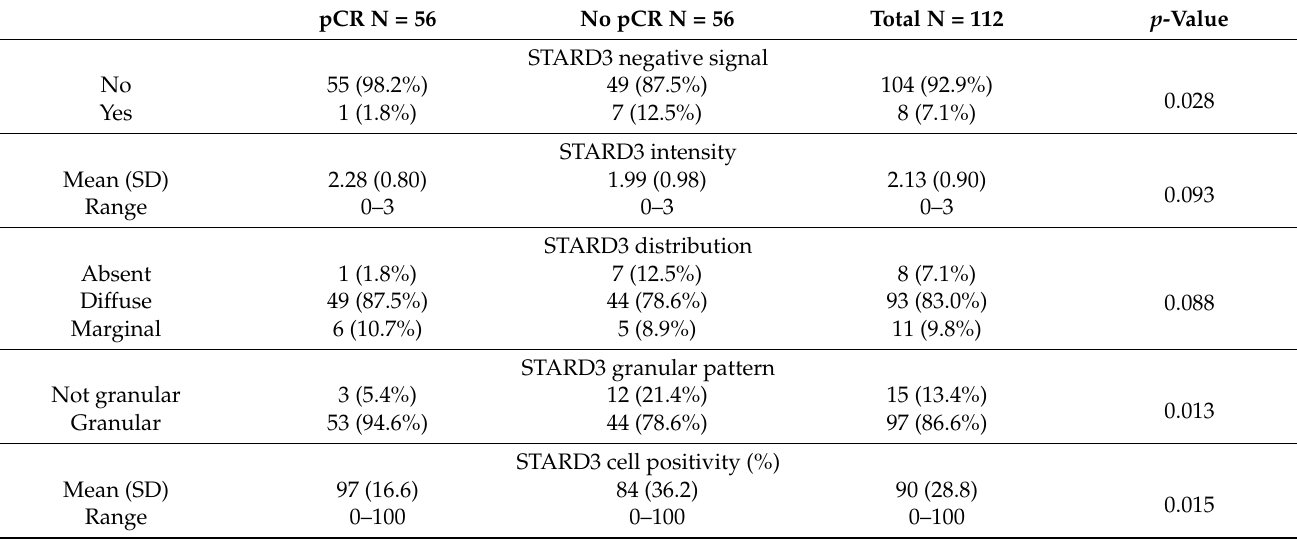
Table 2. STARD3 immunohistochemistry assay according to